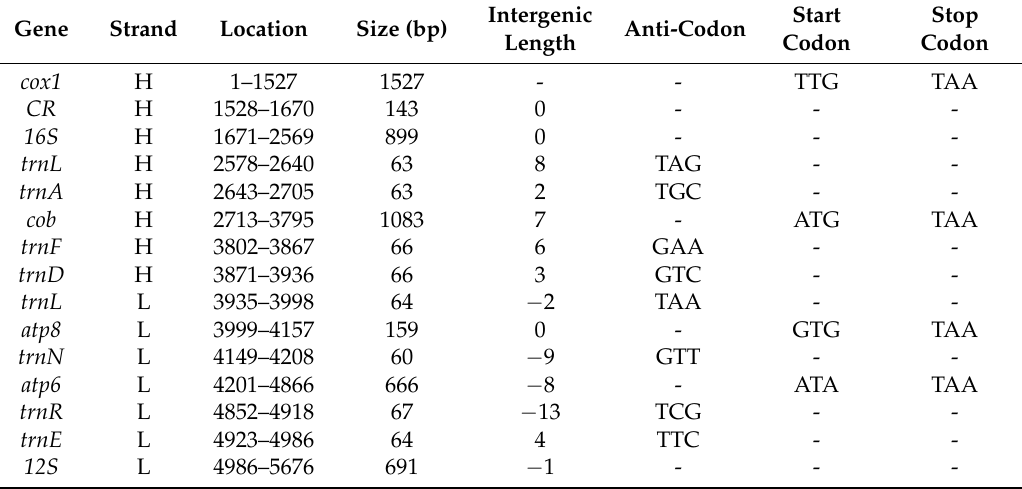
Figure 1. Circular map of the mitogenome of Philomycus bilineatus . The outside and inside of the ring indicate that the gene is encoded by a heavy chain and light chain of mitochondrial genes. Different colors represent different gene families: The yellow shows the NADH dehydrogenase family gene, the pink part is the cytochrome c oxidase family gene, the red shows two different ribosomal RNAs, the green acts as two ATPase family genes, the purple represents the cytochrome c biogenesis gene, and the deep blue region is the translation region of the transport RNA. Table 1. The mitochondrial genome organization of P. bilineatus . H: Heavy strand; L: Light strand.